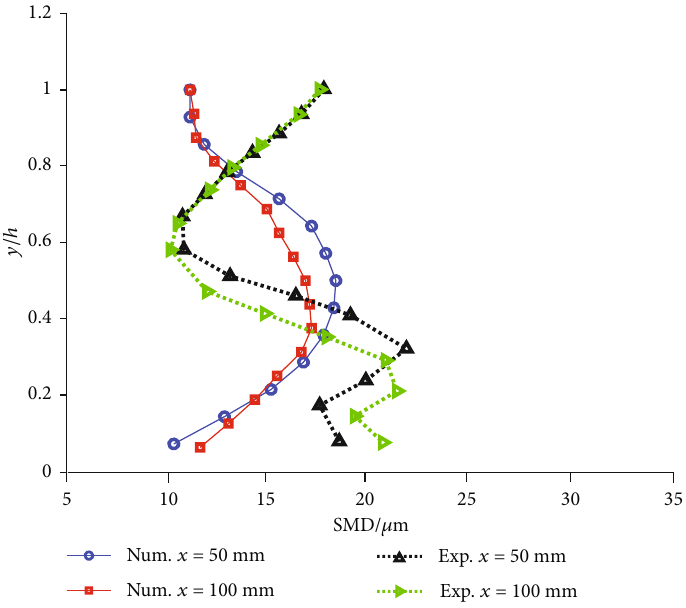
Figure 12: Model veri fi cation in the SMD distribution at di ff erent locations in the central